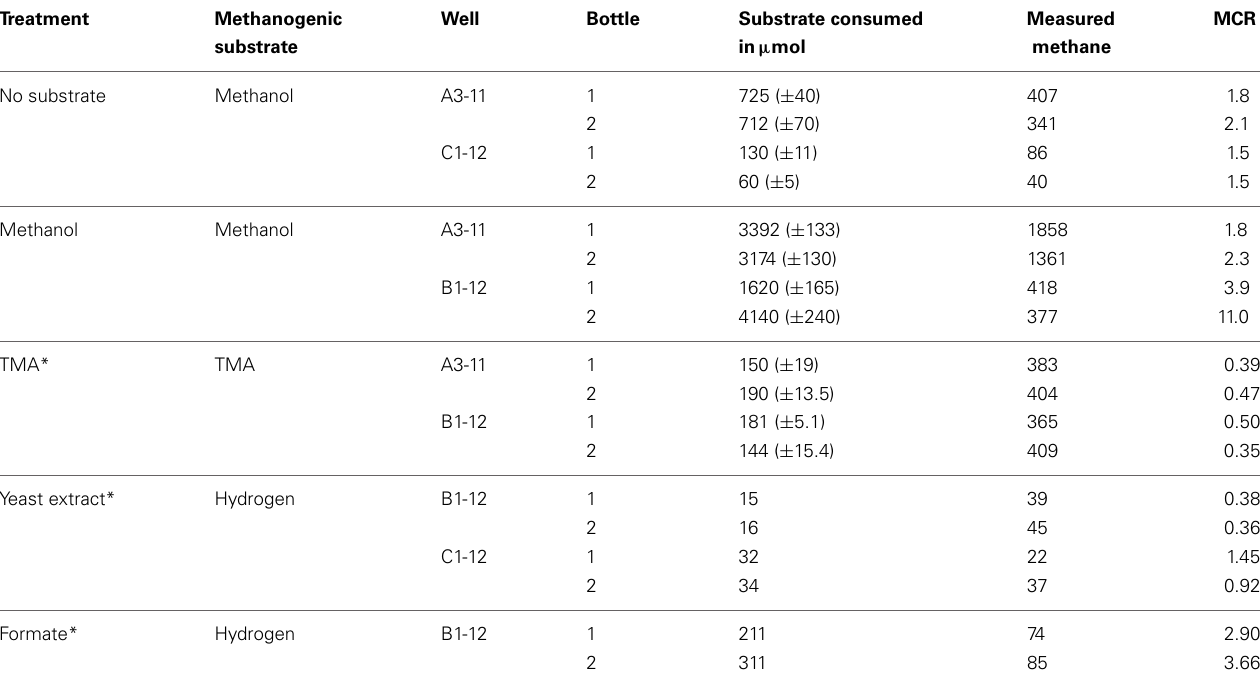
Table 4 | Methanogenic substrate consumption and corresponding methane